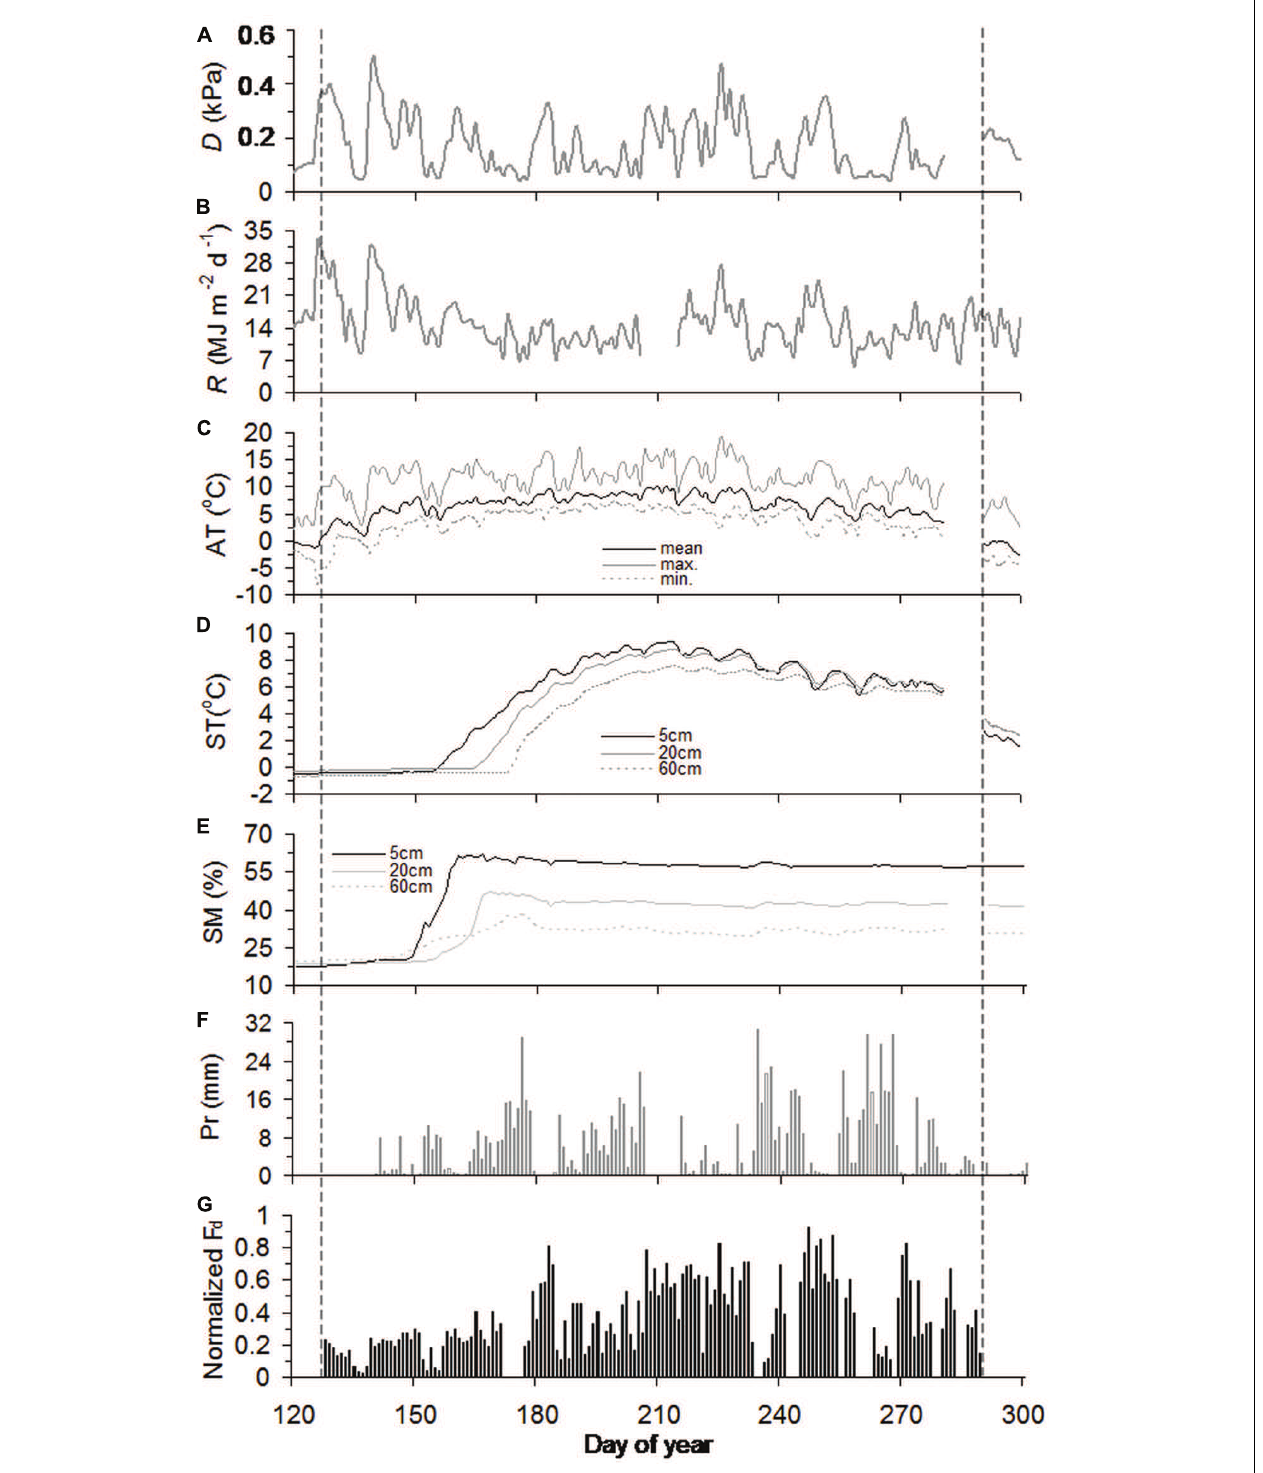
FIGURE 1 | Seasonal course of vapor pressure deficit ( D ) (A), solar radiation ( R ) (B), air temperature (AT) (C), soil temperature (ST) (D), soil moisture (SM) (E), precipitation (Pr) (F), and normalized daily sum sap flow density (normalized F d ) (G) for Smith fir trees during the growing season of 2012. The vertical black dashed lines highlight the timings of onset and ending of sap flow.